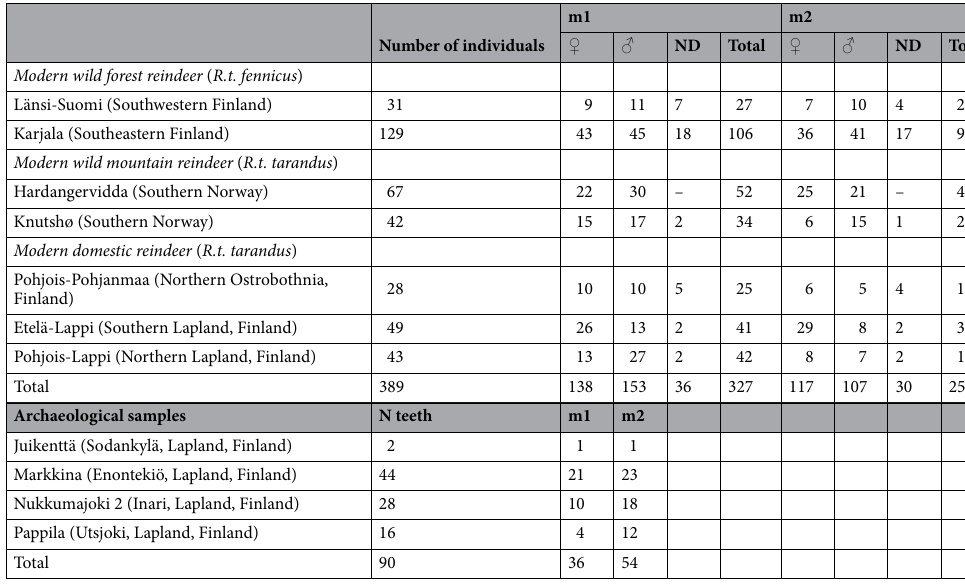
Table 1. Detail of modern specimens studied from the Zoological Museum of Oulu (wild forest reindeer and domestic reindeer from Finland) and the UMR 7041 ArScAn laboratory (wild mountain reindeer from Norway) according to locality, sex (female: ♀ ; male: ♂ ) and tooth (first lower molar: m1; second lower molar: m2), as well as archaeological specimens from the Finnish Heritage Agency of Helsinki, Finland.